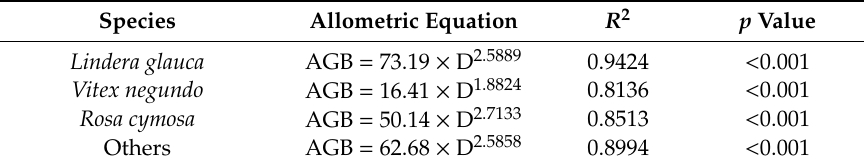
Table 3. Allometric relationships established for aboveground biomass estimation of three dominant shrub species in this study. AGB, aboveground biomass; D, basal diameter of each